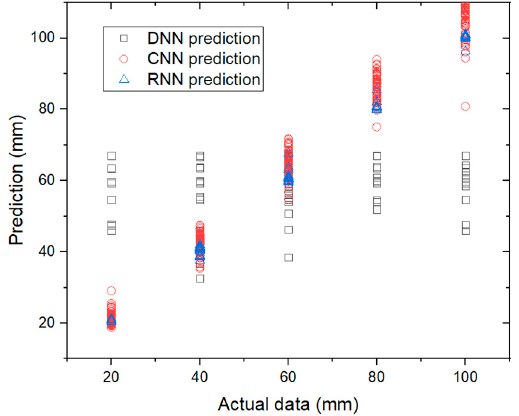
Figure 5. Actual data and prediction of settlement severity regression.